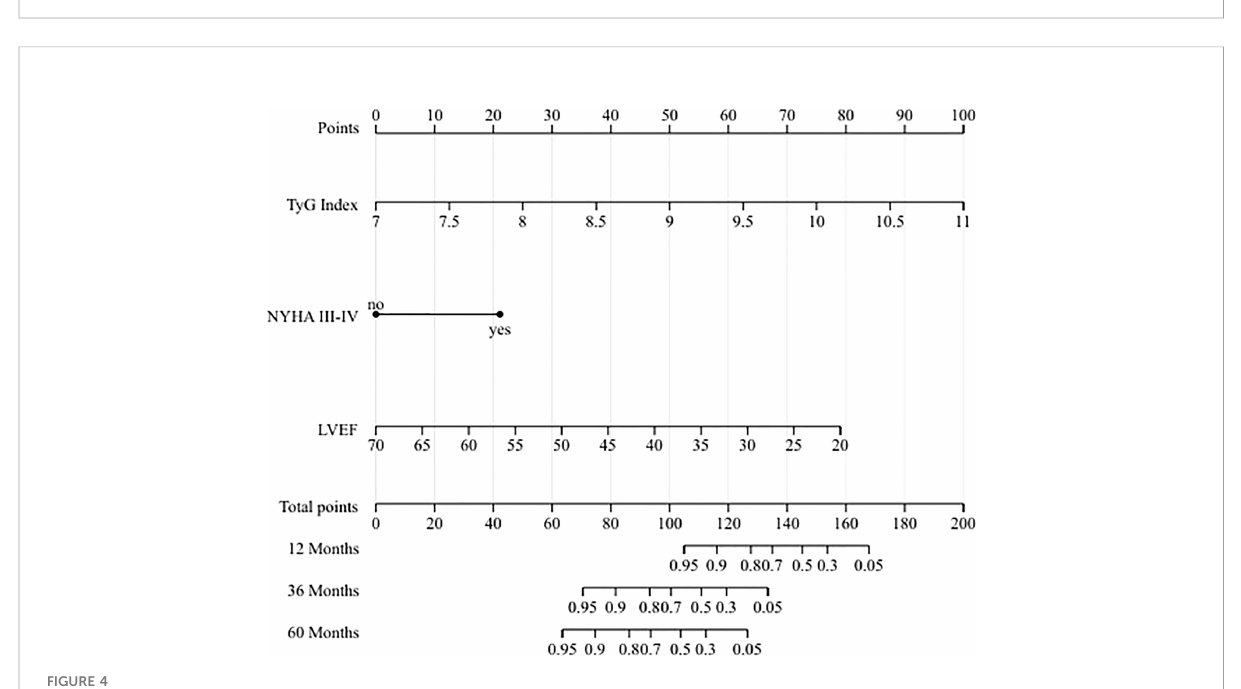
FIGURE 4 Nomogram for predicting 12-/36-/60-months incidence of